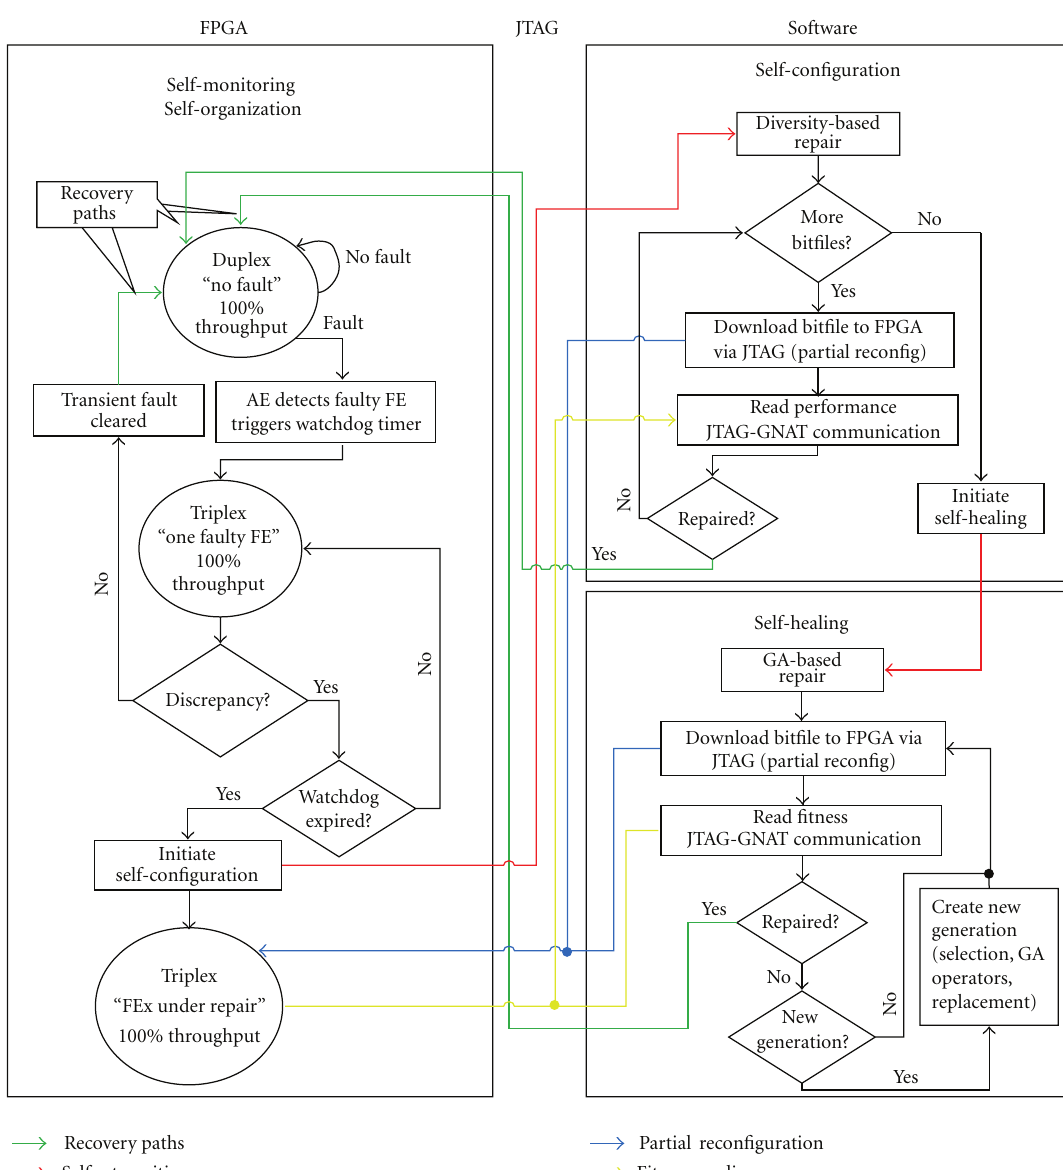
Figure 7: System self-x properties flow and